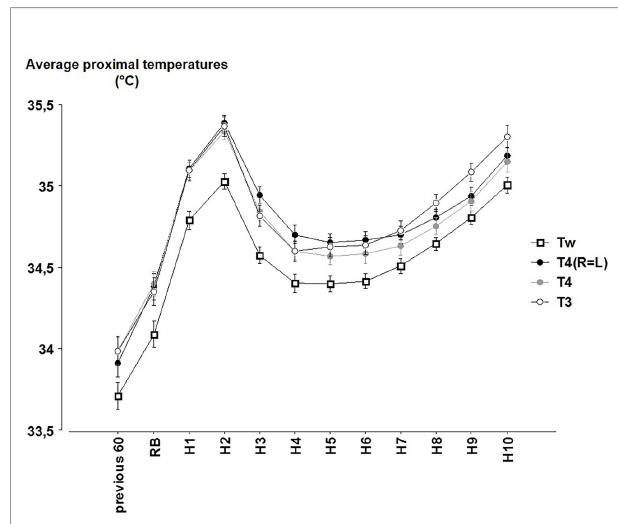
FIGURE 3 | The hourly averages of the different proximal temperatures (Tw = 0.45 T abdo + 0.407 T clav + 0.143 T forehead ; T4(R=L) = 0.33 T abdo + 0.33 T clav + 0.33 T back ; T4 = 0.25 T abdo + 0.25 T right clav + 0.25 T left clav + 0.25 T back ; T3 = 0.33 T abdo + 0.33 T right clav + 0.33 T left clav ) (mean ± SEM) according to the time (Previous 60 = during the 60 min before reported bedtime (RB). H1 to H10 hours in